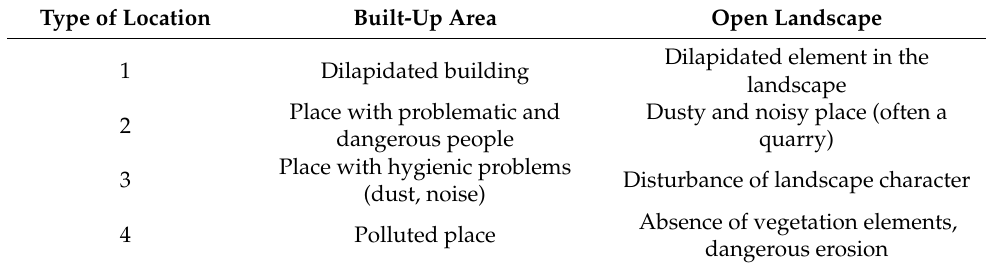
Table 3. Reason for preference: problematic locations—evaluated by all respondents. Type of